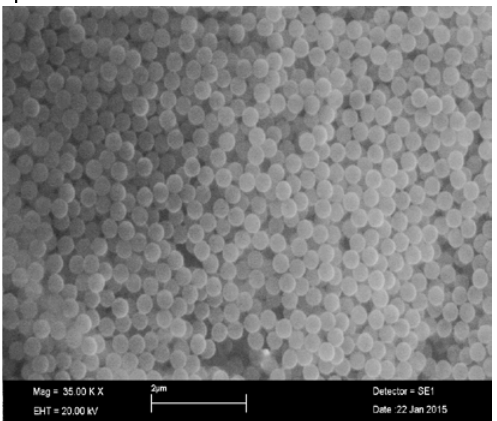
Fig.6: SEM image of necking formation between the